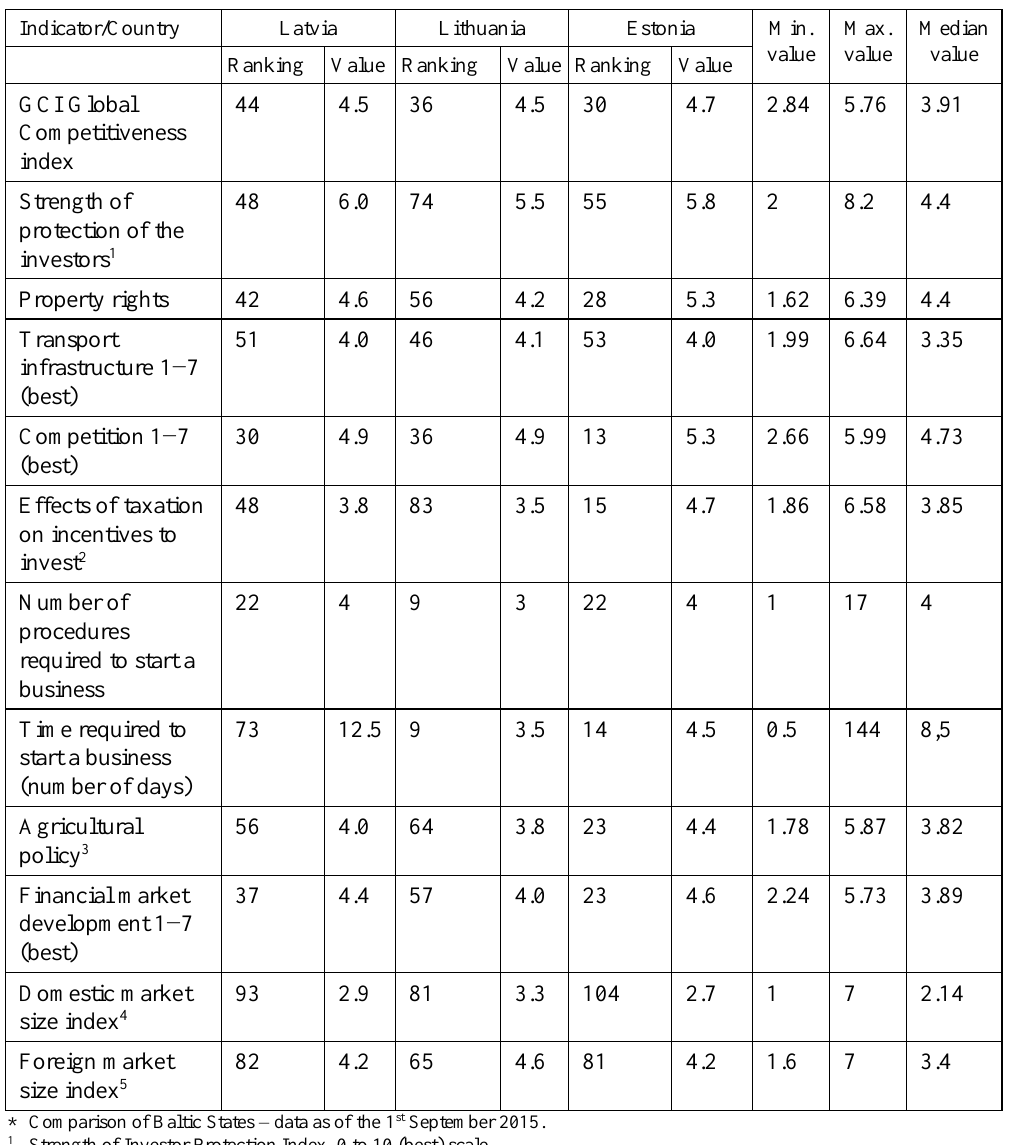
Table 1. Factors, which are affecting the economy and property market ranking indicators in the Baltic States. Data source: World Economic Forum, 2016, table made by